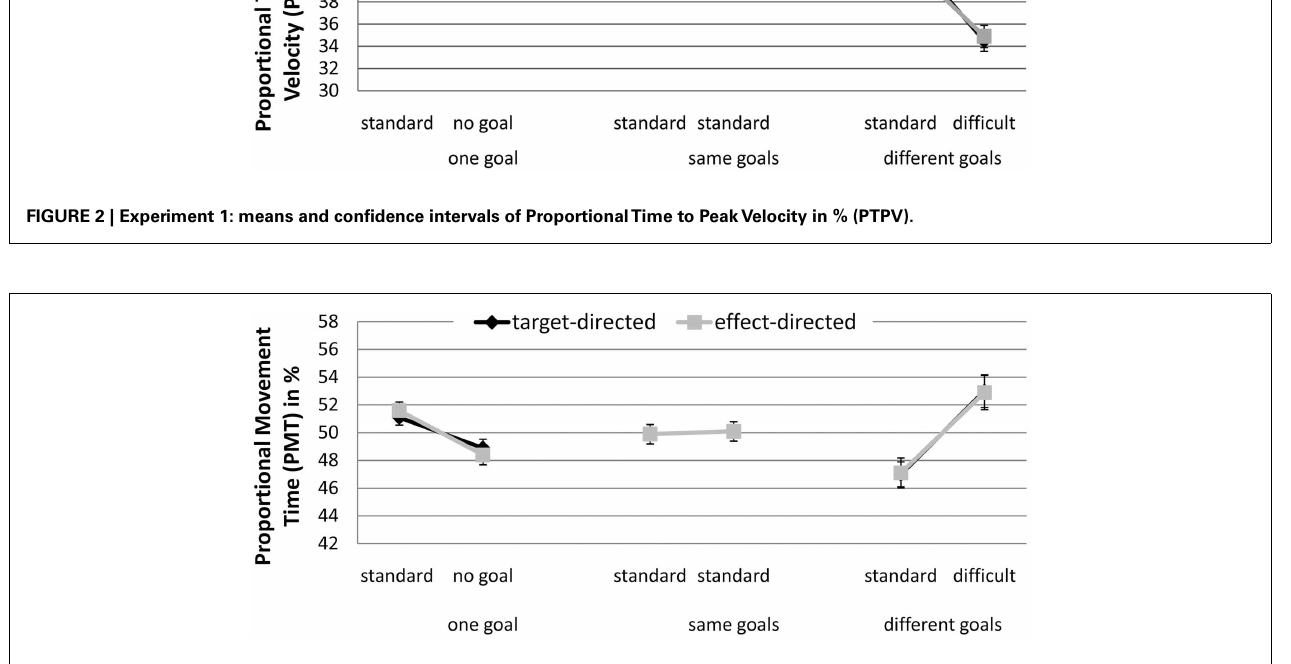
FIGURE 3 | Experiment 1: means and confidence intervals of Proportional MovementTime in % (PMT).